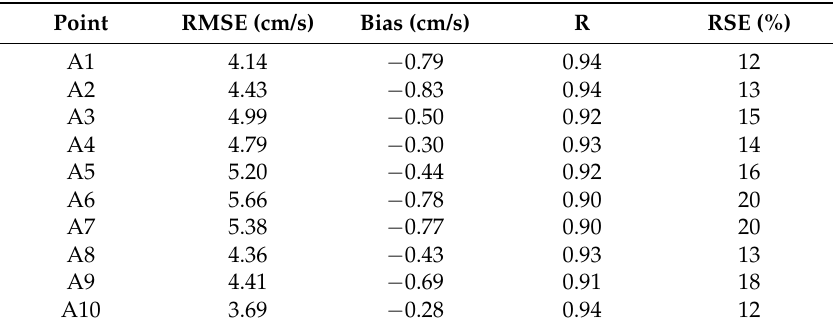
Table 7. Statistics of v velocity component forecasts (Model V9, 1 h forecast window).